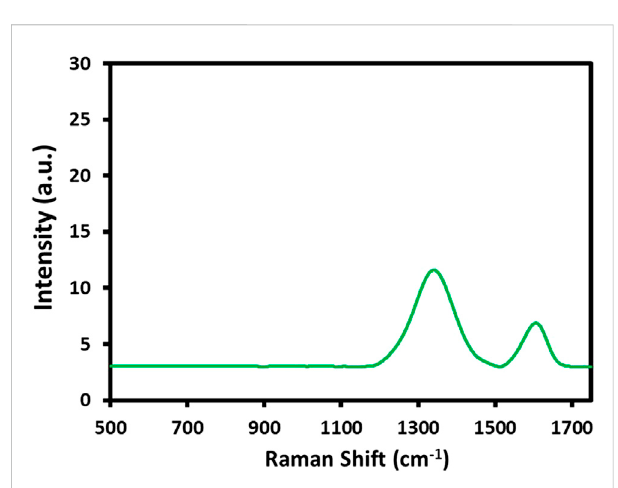
FIGURE 4 Raman analysis of highly reduced graphene oxide (HRG).